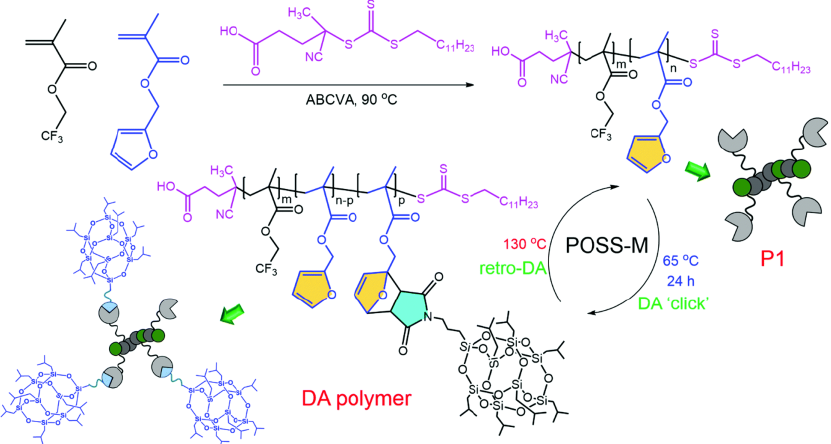
Figure 15. Copolymerization of FMA and TFEMA and subsequent modification of the prepared polymer with POSS-M. Reproduced from Polym. Chem . 2021, 12 , 876–884. Ref. [75] with permission from the Royal Society of Chemistry.